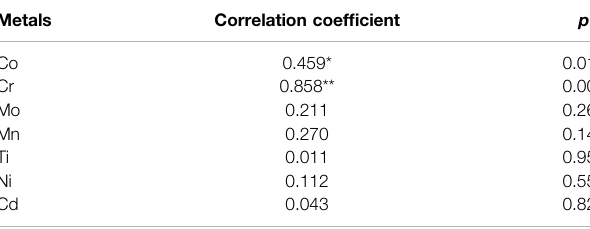
TABLE 4 | Pearson correlation analysis between metal concentration and the expression of cleaved Caspase three protein in the oral